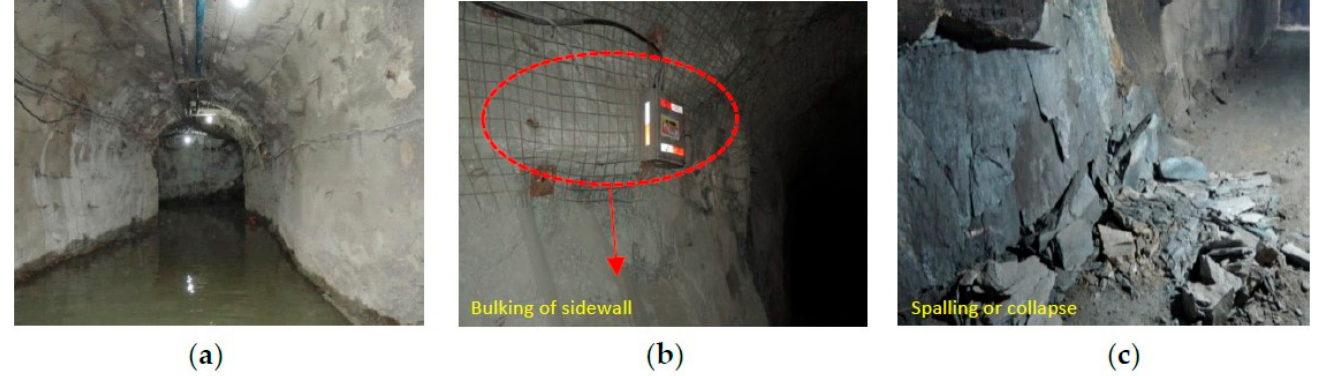
Figure 3. Failure characteristics of different levels of tunnels in the Ashele Copper Mine. ( a ) No damage; ( b ) slight damage; ( c ) moderate damage.